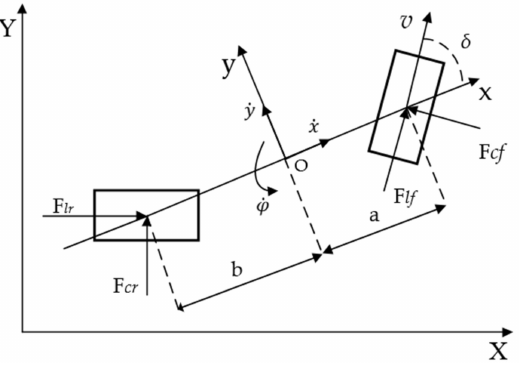
Figure 5. Vehicle dynamics